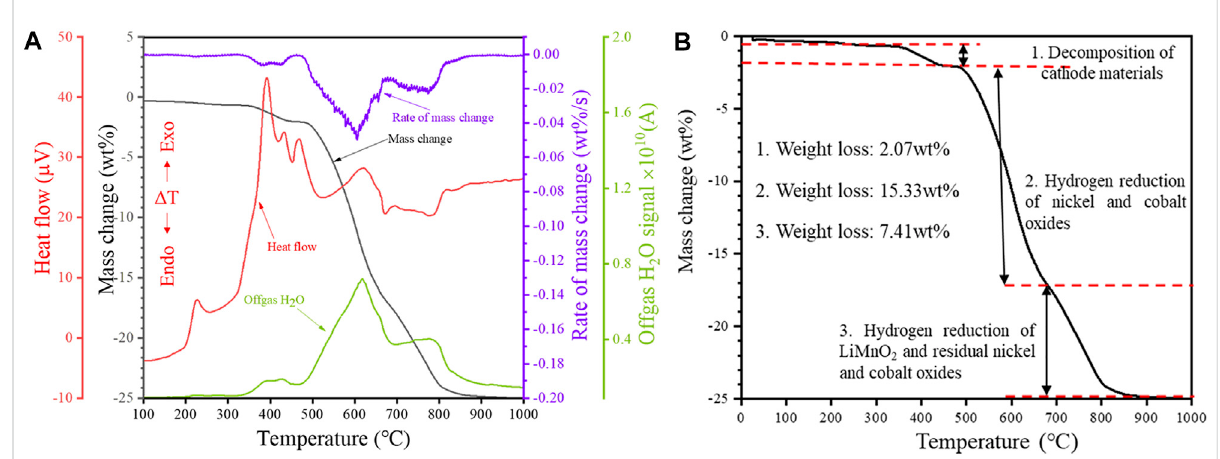
FIGURE 2 Non-isothermal reduction of the cathode powders: (A) TG-DTA-MS pro fi le and (B) TG pro fi le showing the possible reduction stages (Heating rate 20 ° C/min, H 2 concentration 20 vol%).